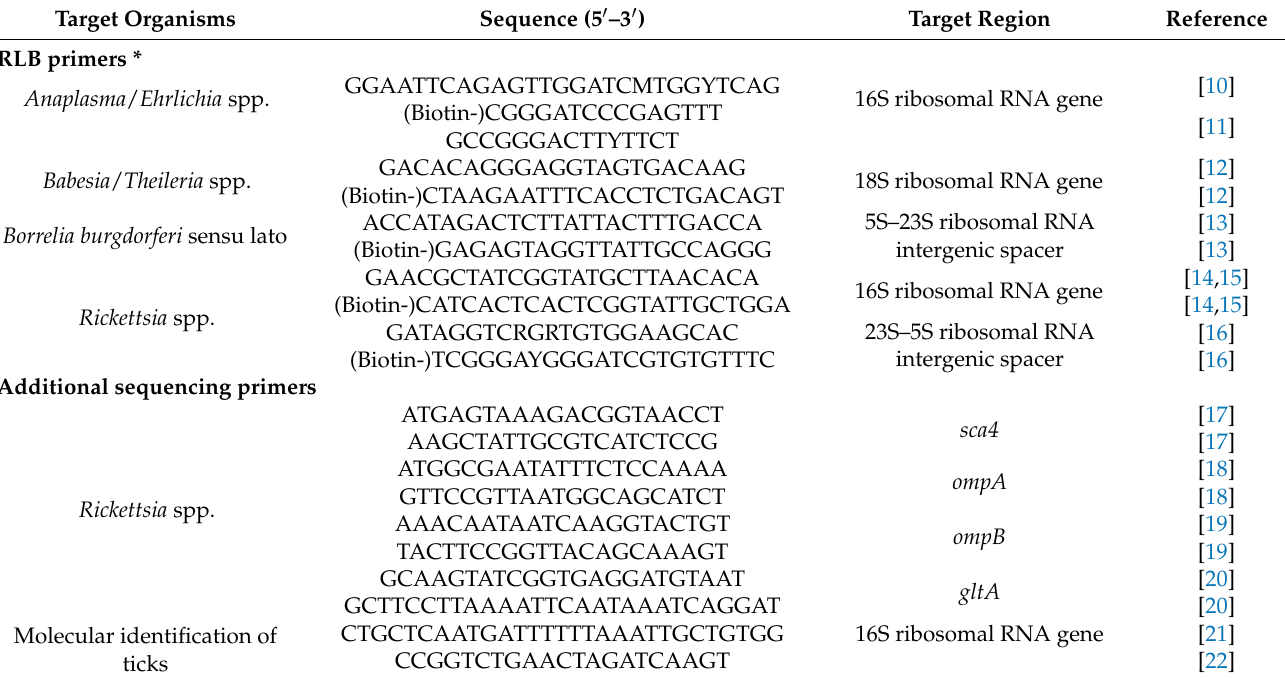
Table 1. Primers used for the reverse line blot and